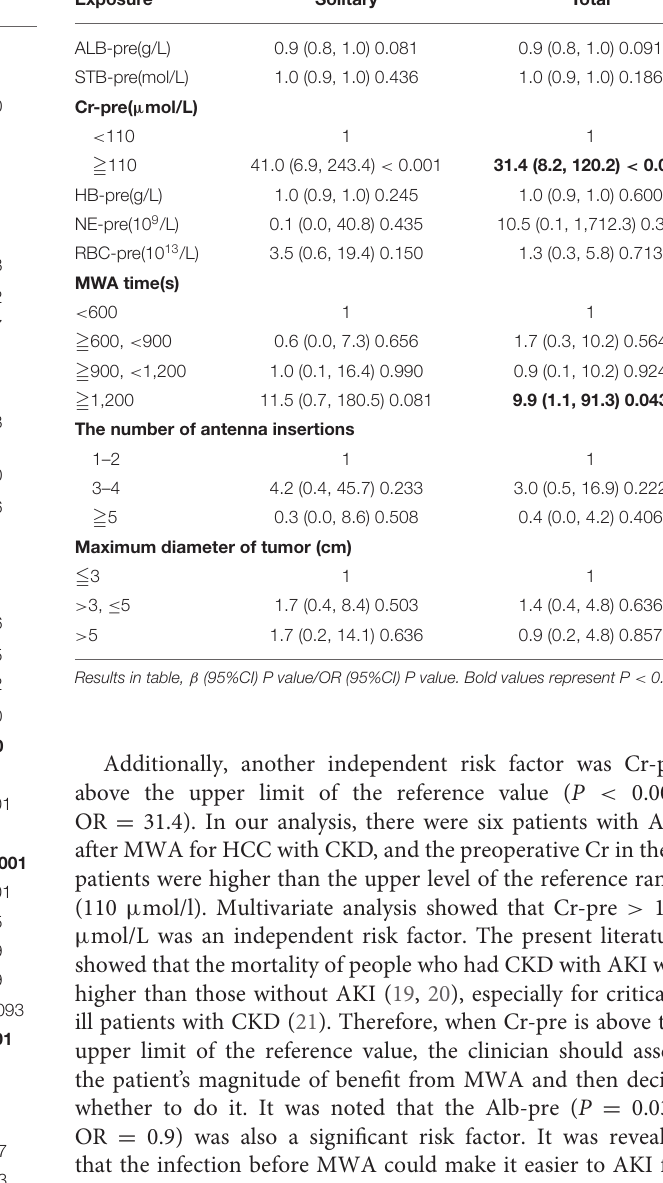
TABLE 3 | Univariate analysis for acute kidney injury (AKI) (stages 1b, 2, and 3) for risk factors. Exposure Solitary Total